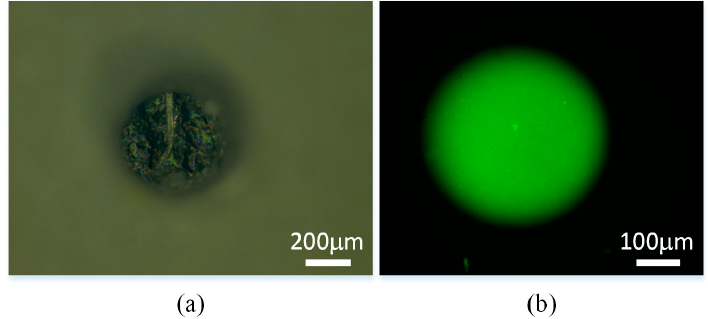
Figure 5. ( a ) Punched hole of 500 µm in diameter and ( b ) corresponding generated hydrogel observed with fluorescence microscope.